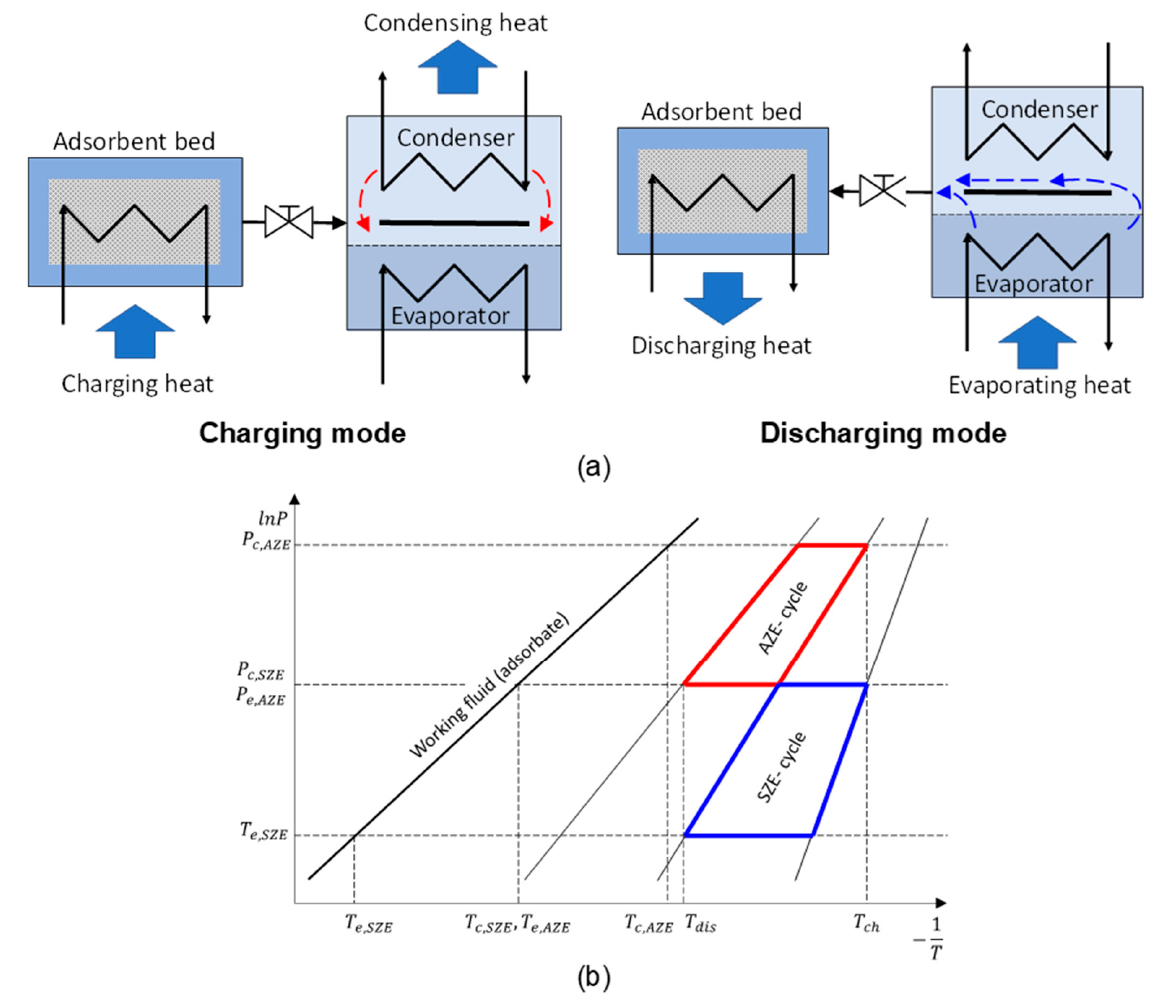
Figure 2. Clapeyron diagram for the studied heat storage cycles. This study considered two cycles: above-zero evaporation (AZE) and sub-zero evapo- ration (SZE) heat storage cycle. In AZE, the ambient temperature of 10 ◦ C was considered, which acts as a heat source for the evaporator at 5 ◦ C and heat sink for the condenser at